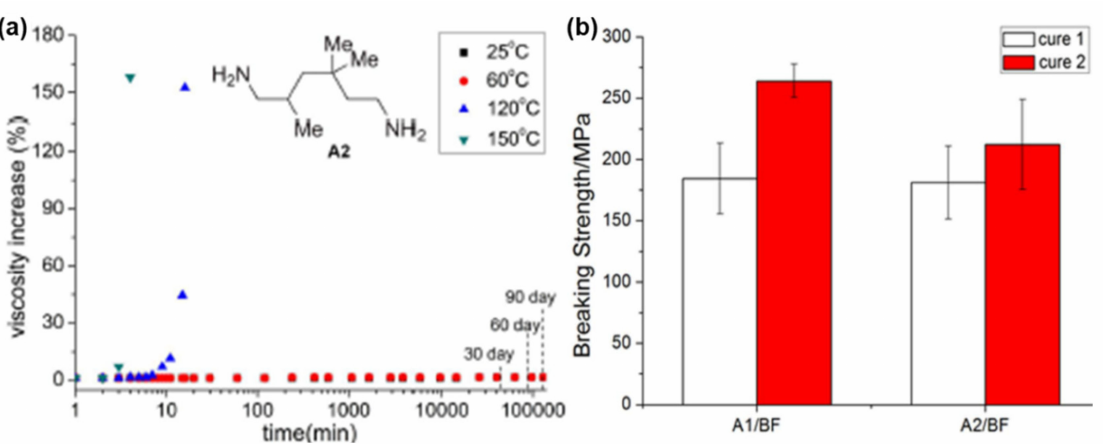
Figure 53. ( a ) Time dependence of viscosity of reactive mixture A2/BF stored at 25, 60, 120, and 150 ◦ C, ( b ) material proper- ties of cured resins: breaking tensile strength [340]. Copyright 2016. Reproduced with permission from Springer